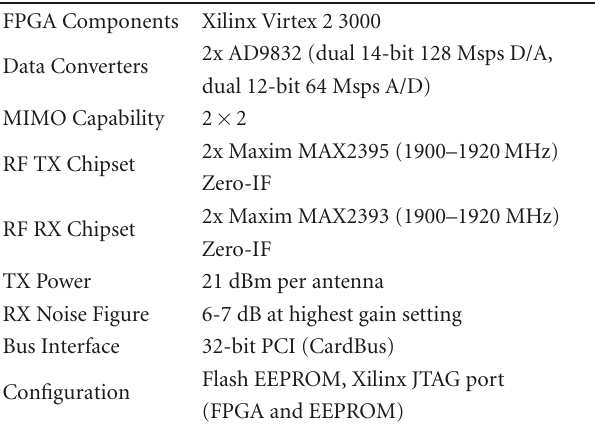
Table 1: Hardware characteristics of the CardBus MIMO1 card.